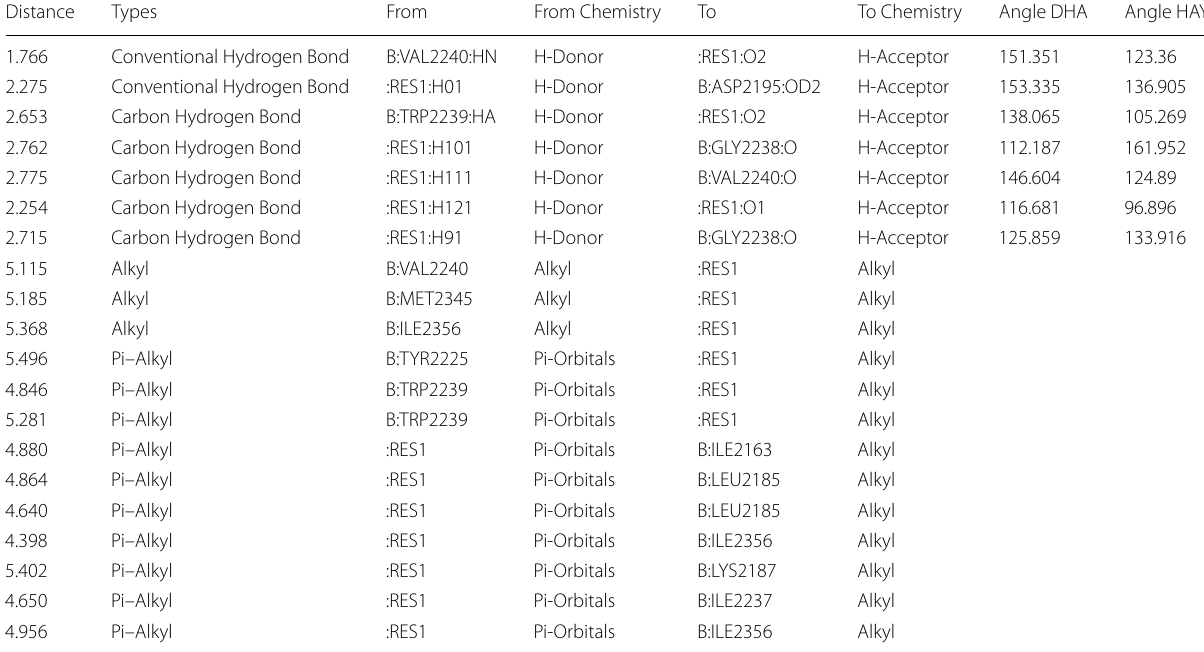
Table 3 Types of interactions in the Reference ligand (X6K)-4JT6 (mTOR) receptor